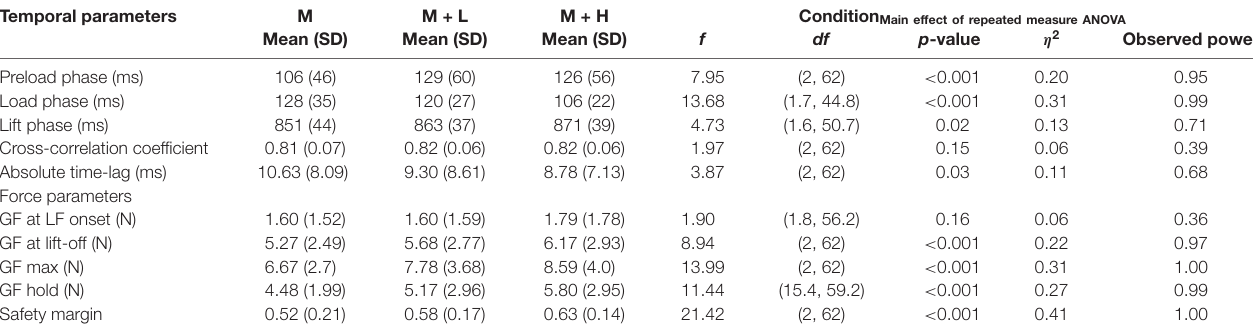
TABLE 1 | Mean and standard deviation (SD) of the parameters of the grip-lift task performed in the M, M + L and M + H conditions; and main effect of condition on these parameters. Temporal parameters M M + L M + H Condition Main effect of repeated measure ANOVA Mean (SD) Mean (SD) Mean (SD) f df p -value η 2 Observed power Preload phase (ms)